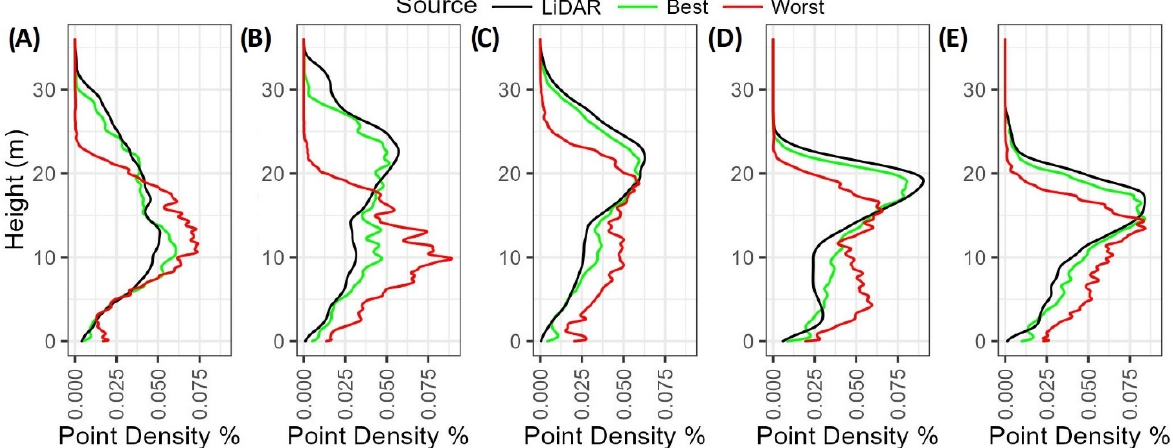
Figure 5. Relative density as a function of height above ground for the models providing the best and worst model ∆ R 2 from the Standard SfM AGB datasets compared to the LiDAR at each site (from left to right ( A ) KNF1, ( B ) KNF2, ( C ) KNF3, ( D ) MEF1, and ( E ) MEF2).